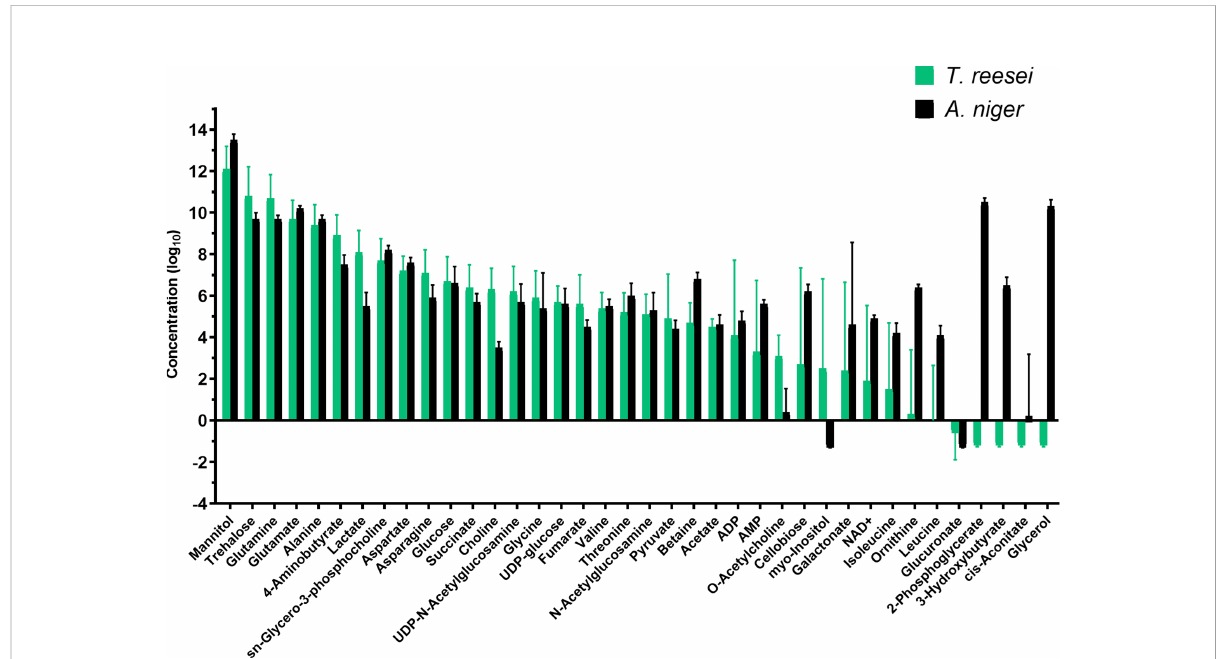
FIGURE 7 Metabolic pro fi le of T. reesei and A. niger grown on SEB for 48 h. The pool size of each metabolite was normalized by the total mass of mycelia and SEB, and converted into log 10